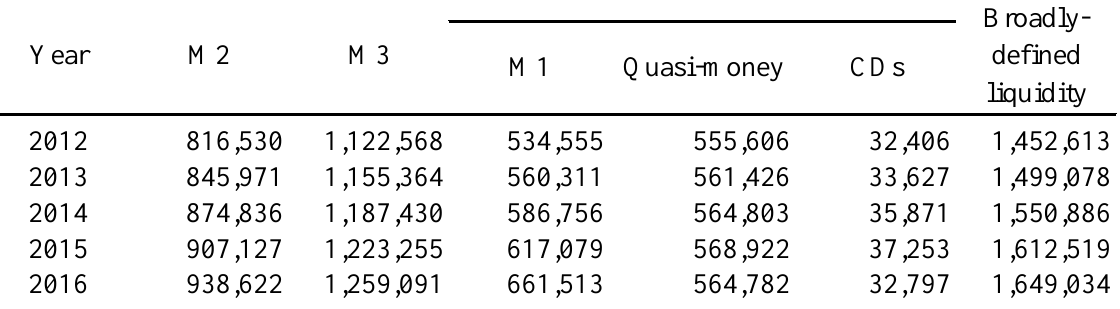
Money Stock 1) (Average amounts